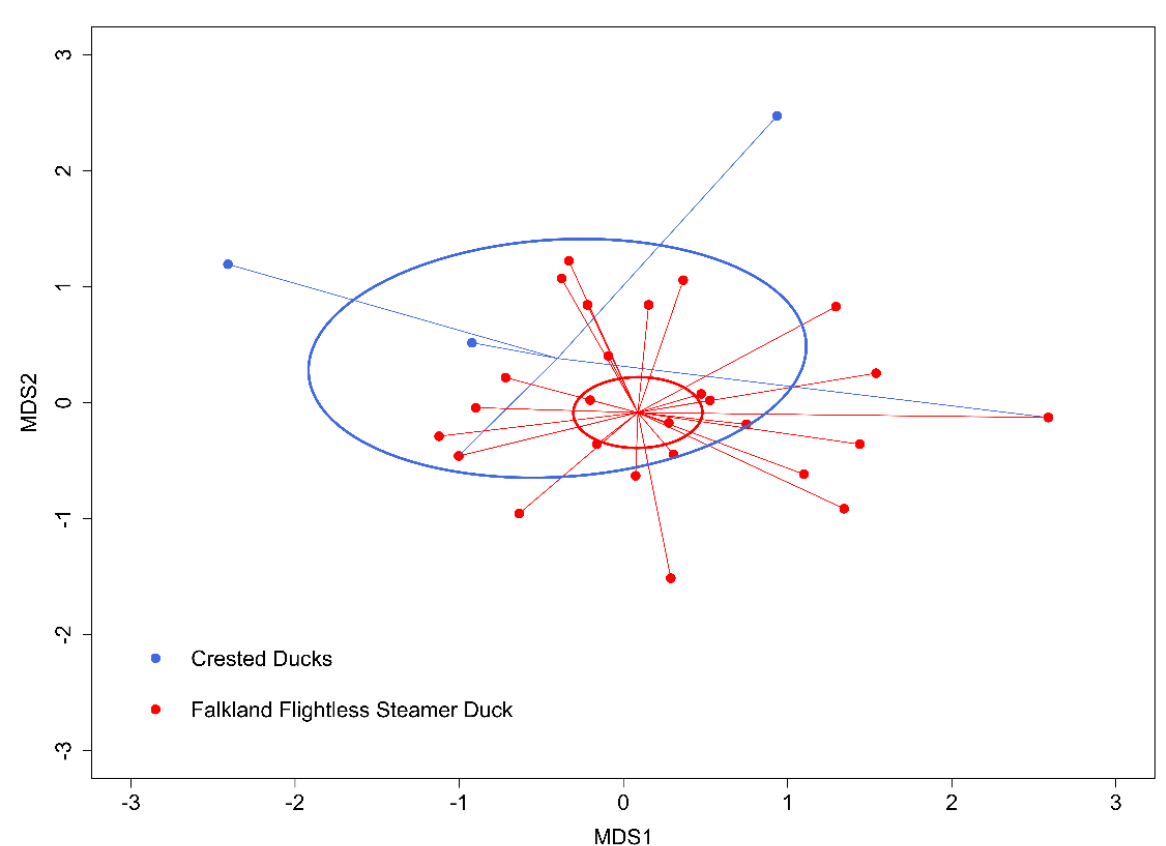
Figure 1. Differences in diet composition between Falkland Flightless Steamer Duck Tachyeres brachydactyla and Patagonian Crested Duck Lophonetta specularoides . Data correspond to individuals foraging on the coast of New Island, Falkland/Malvinas Islands, from October 2017 to February 2019. We used non − metric multidimensional scaling of molecular operational taxonomic units to collapse information from multiple dimensions into two dimensions to facilitate visualization and interpretation. The ellipses and lines connect similar categories.